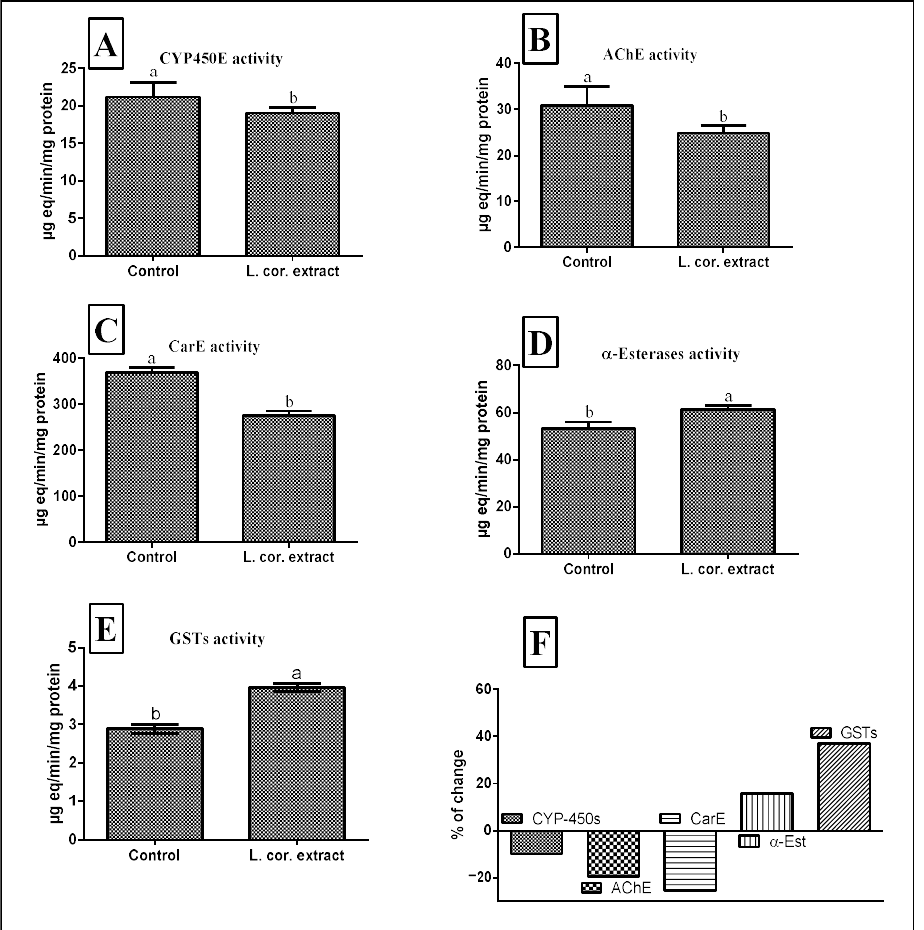
Figure 3. Effects of L. coronopifolia extract (L. cor.) on the enzymatic activities of cytochrome P-450 monooxygenase (CYP-450s) ( A ), carboxylesterase (CarE) ( B ), acetylcholinesterase (AchE) ( C ), α-esterases ( D ), and glutathione S-transferase (GSTs) ( E ) in the 3rd larval instar of C. Pipiens . ( F ); % of changes. Data were represented as mean ± SE. Lowercase letters above the bars indicate significant differences between different treatment groups (Duncan’s multiple range test, p < 0.01). Error bars indicate 95% confidence intervals.